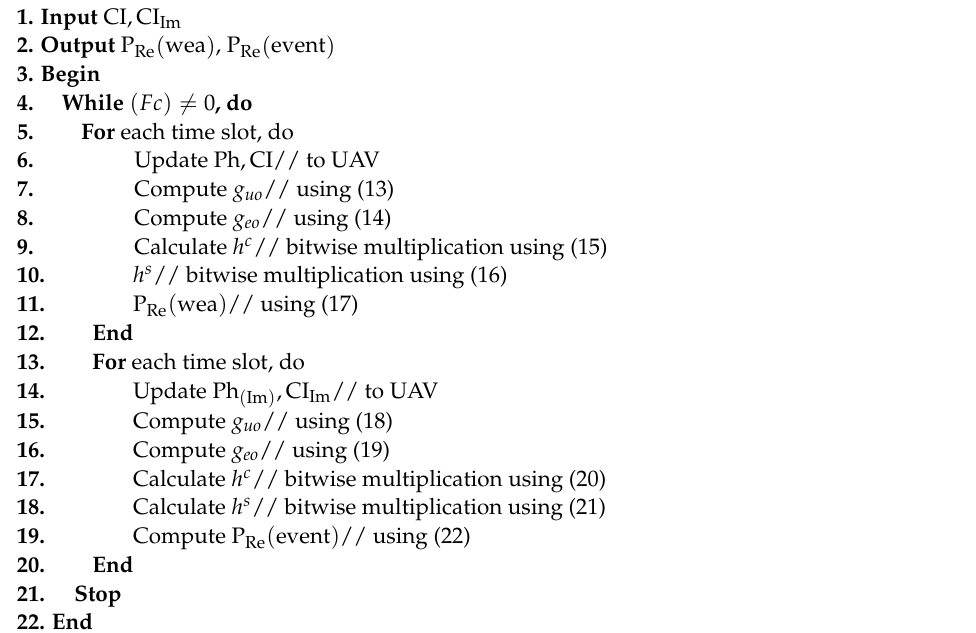
Algorithm 1 LGRU ‐ based weather and event